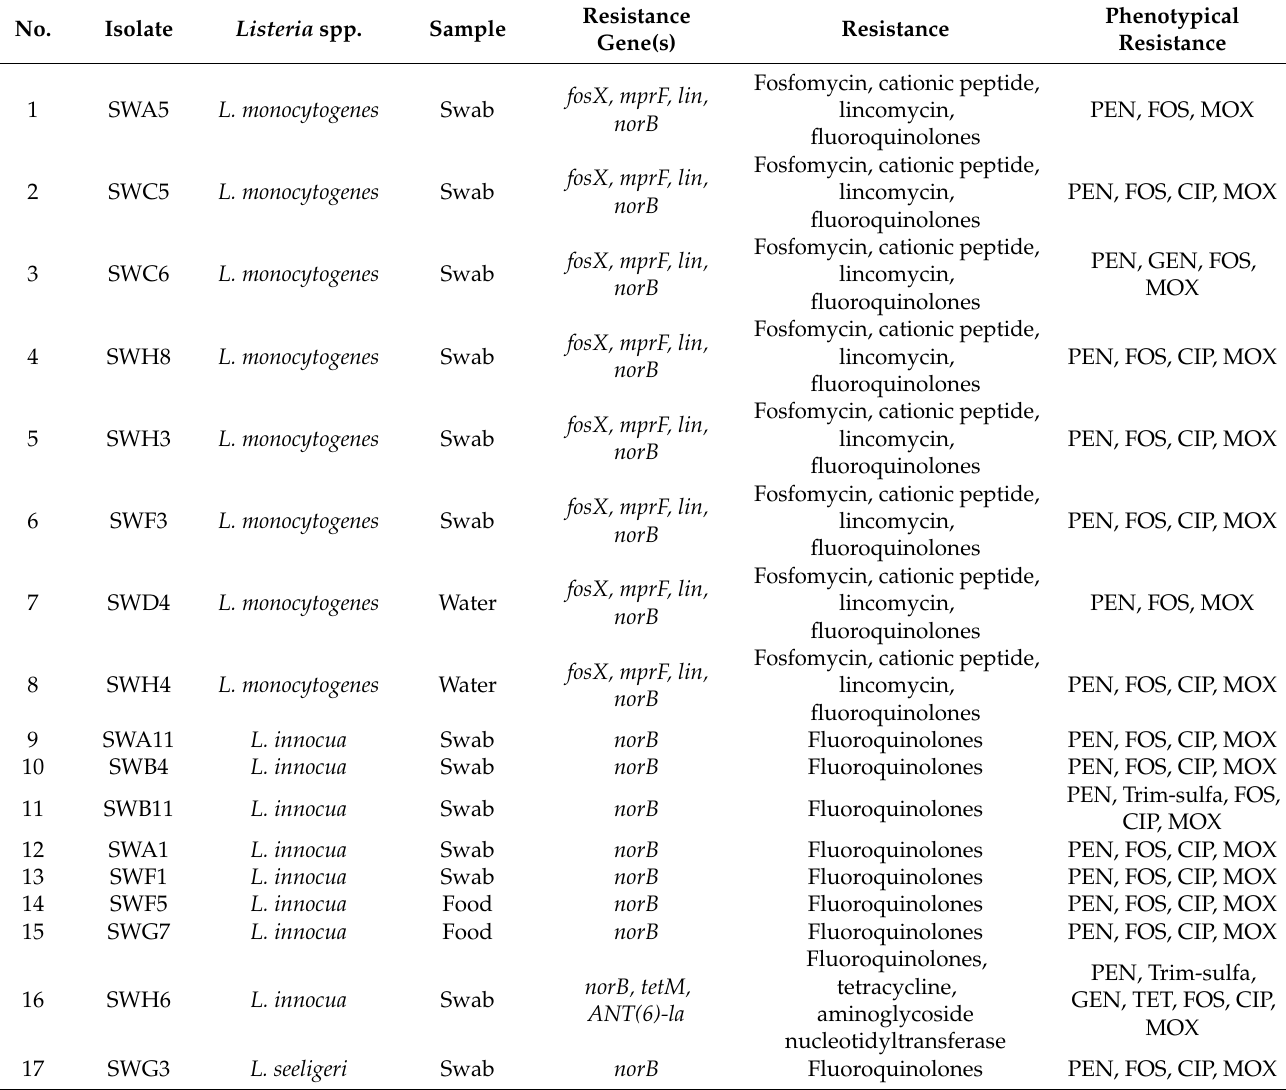
Table 2. AMR genes and phenotypically detected resistances of 17 Listeria